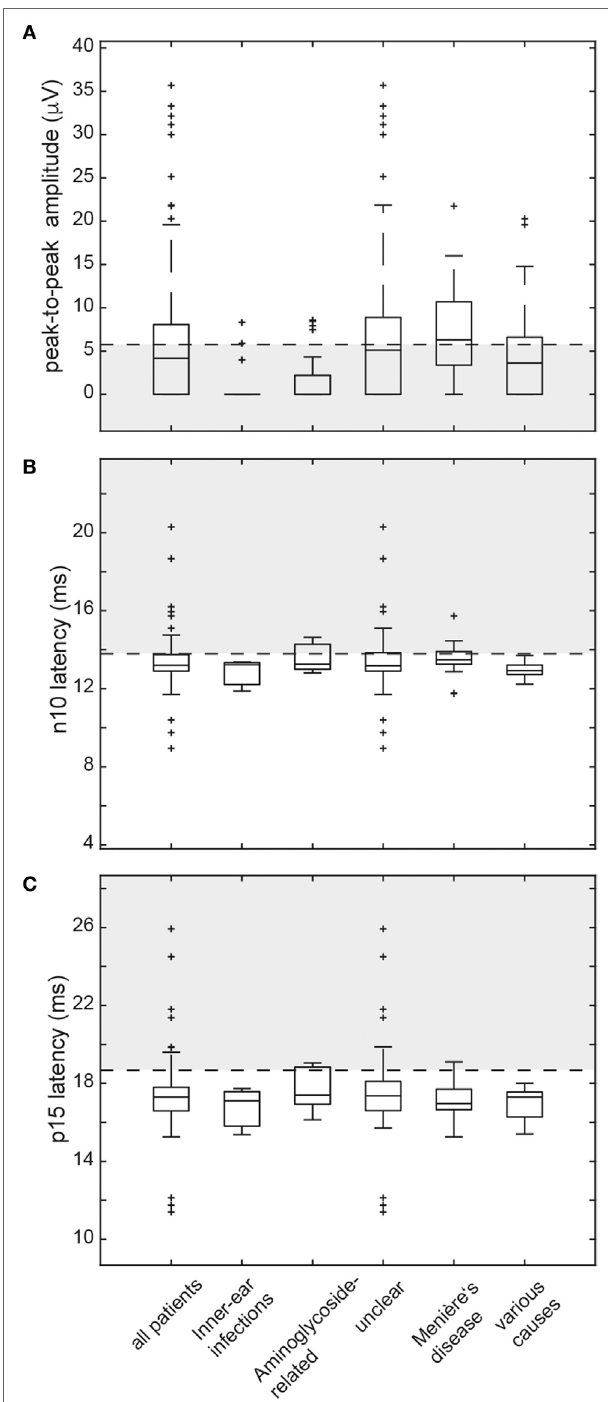
FigUre 3 | Box and whisker plots illustrating both peak-to-peak amplitudes ( μ V) and latencies (ms) for ocular vestibular-evoked myogenic potentials (oVEMPs) in all patients. For peak-to-peak (n10–p15) amplitudes (a) , a horizontal dashed line refers to the lower limit of normal (i.e., the 5th percentile of amplitudes measured in the healthy controls). The gray shaded area below indicates significantly reduced amplitudes. For both n10 latencies (B) and p15 latencies (c) , the upper limit of normal (i.e., the 95th percentile of latency values in the healthy controls) is indicated by a horizontal dashed line. The gray shaded area above refers to significantly increased latencies. The box has lines at the lower quartile, the median, and the upper quartile values. Whiskers extend from each end of the box to 1.5 times the interquartile range from the ends of the box. Outliers (black “ + ” sign) are data with values beyond the ends of the whiskers. Note that subjects with absent oVEMP responses are not shown on this